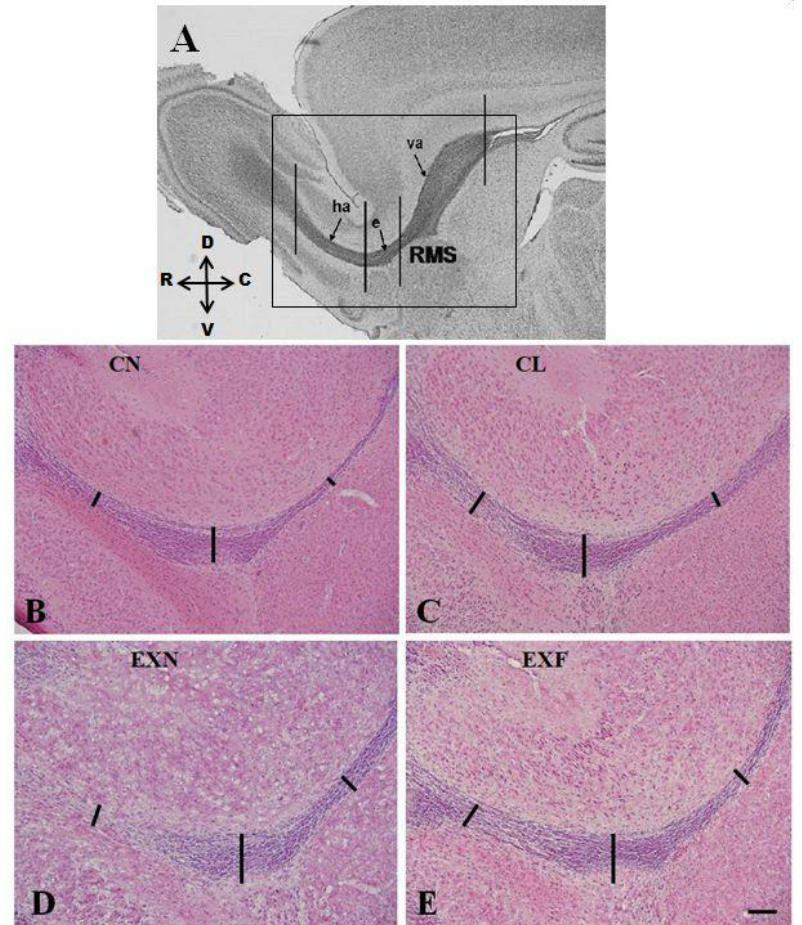
Figure 1. Microphotographs of parasagittal sections of the RMS of mice with various body conditions stained with hematoxylin-eosin. ( A ) Micrograph showing individual anatomical parts of the RMS: va — vertical arm, e — elbow, ha — horizontal arm. ( B – E ) The dark violet staining, an indicator of cell density distinguishes the RMS from other areas of the forebrain. Note the increase in the thickness of the RMS caudal parts (the vertical arm and the elbow) in CL, EXN and EXF mice when compared to controls (black lines). Abbreviations: (CN) control group of mice characterized by normal weight and physiological percentage of body fat deposits; (CL) control group of mice characterized by reduced weight and reduced body fat deposits; (EXN) experimental group of mice characterized by normal weight and moderately elevated body fat deposits; (EXF) experimental group of mice characterized by markedly elevated weight and body fat deposits; RMS — rostral migratory stream, C-caudal, R-rostral, D-dorsal, V- ventral. Scale bar = 100 μm.